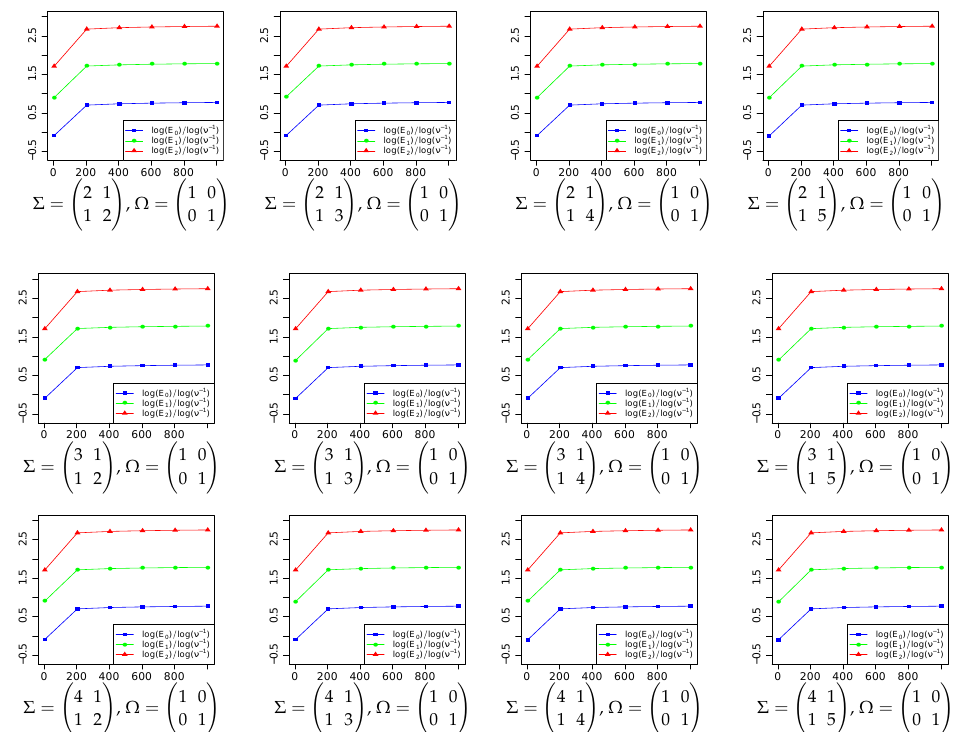
Figure 1. Plots of log E i / log ( ν − 1 ) as a function of ν , for various choices of Σ . The plots confirm (5) for our choices of Σ and bring strong evidence for the validity of Theorem 1.